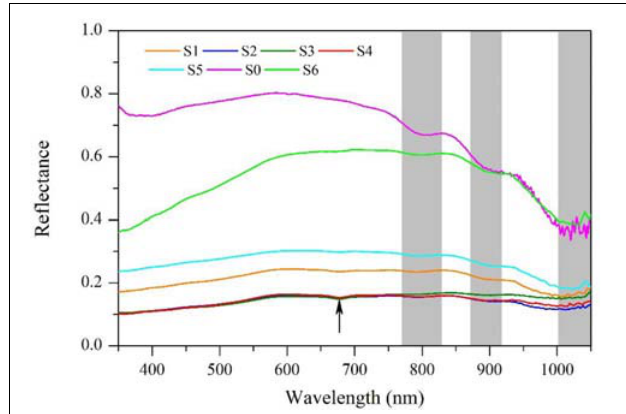
FIGURE 7 | The reflectance spectrum curves in wavelength ranged from 350 to 1050 nm on the surface of the Urumqi Glacier No. 1. S0 was collected over the pure aged snow surface of Urumqi Glacier No. 1 (Yue et al., 2017). The arrow shows absorption feature at 670–680 nm due to chlorophyll in the surface dust. The gray bands mark the known absorption wavelengths for